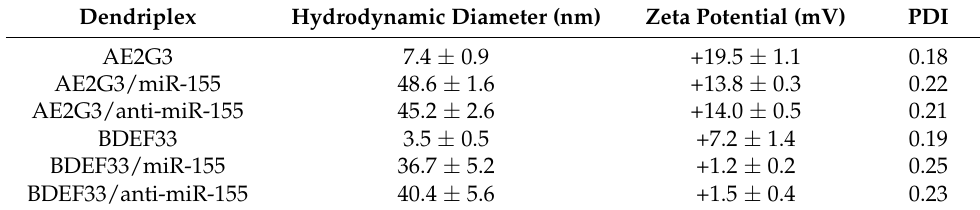
Table 2. Characteristics of dendriplexes